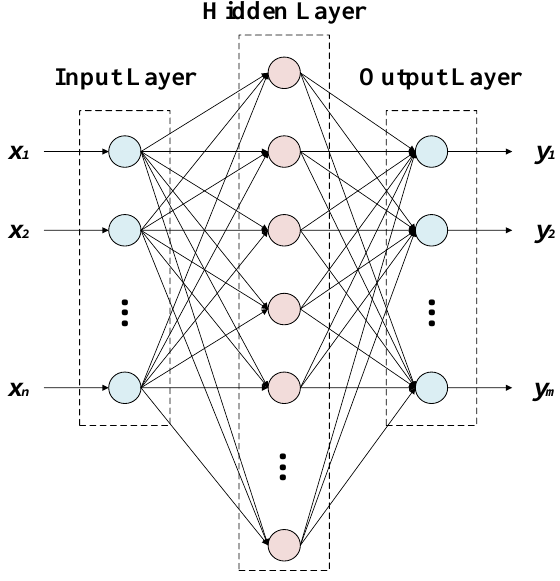
Figure 1. Three-layer neural network.